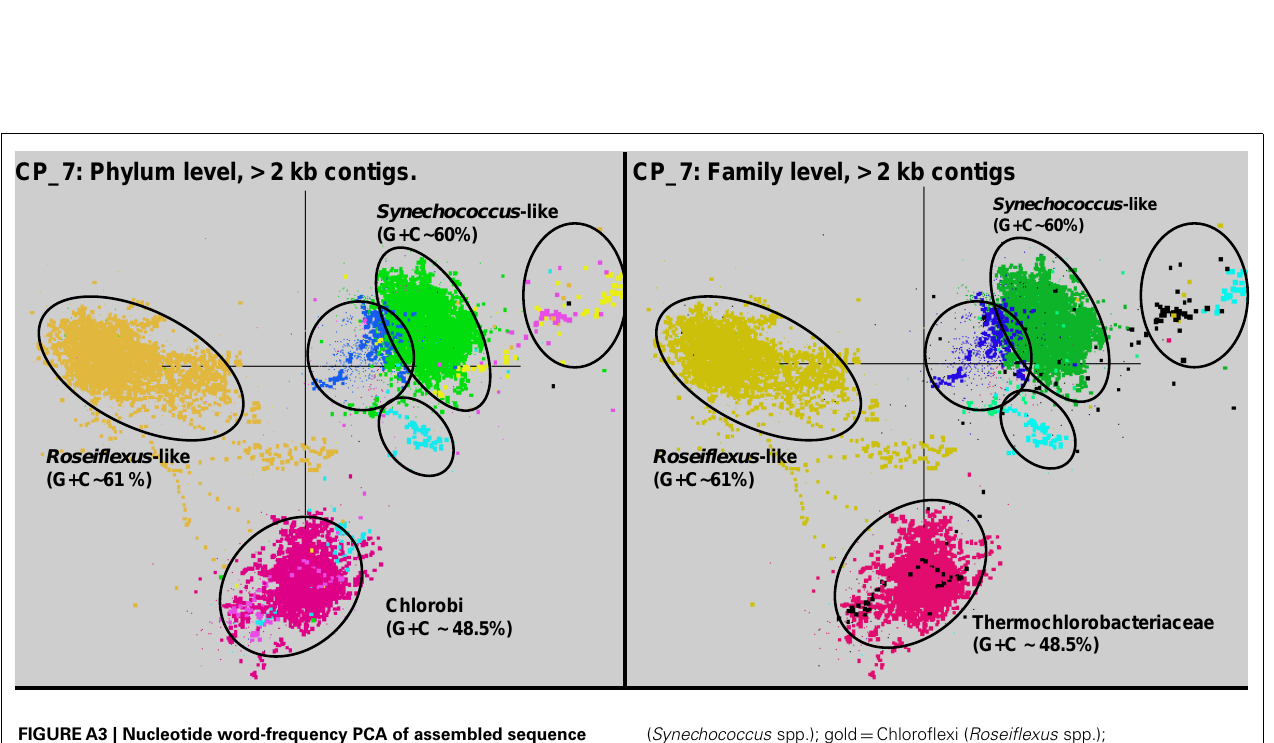
FIGUREA3 | Nucleotide word-frequency PCA of assembled sequence from Chocolate Pots (CP_7) .This community contains predominant phylotypes of Roseiflexus -, Synechococcus -, “ Ca .T. aerophilum”- (Chlorobi), and Leptospirillum -like populations as well as minor contributions from the Firmicutes, Proteobacteria, and Bacteroidetes [green = Cyanobacteria